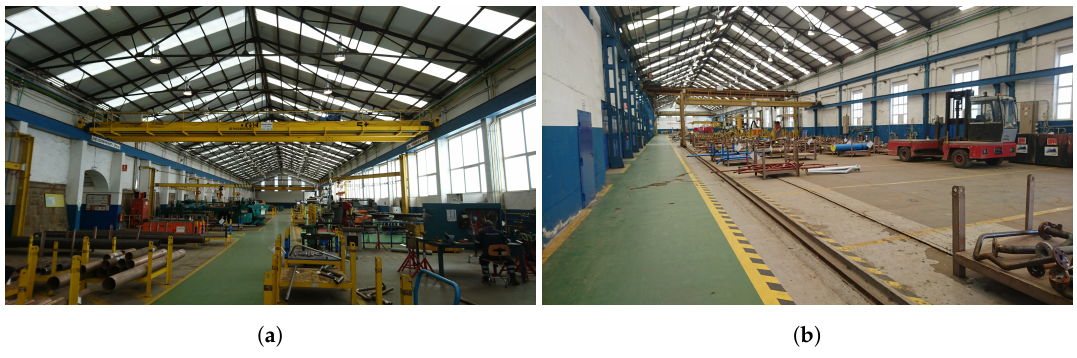
Figure 1. Left ( a ) and right ( b ) wings of the pipe